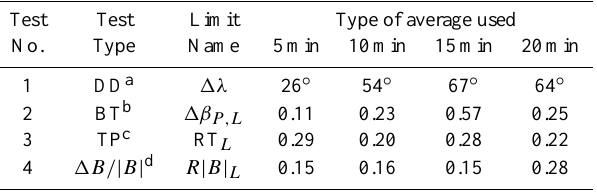
Table 2. Criteria limit-values found through M-function optimiza-